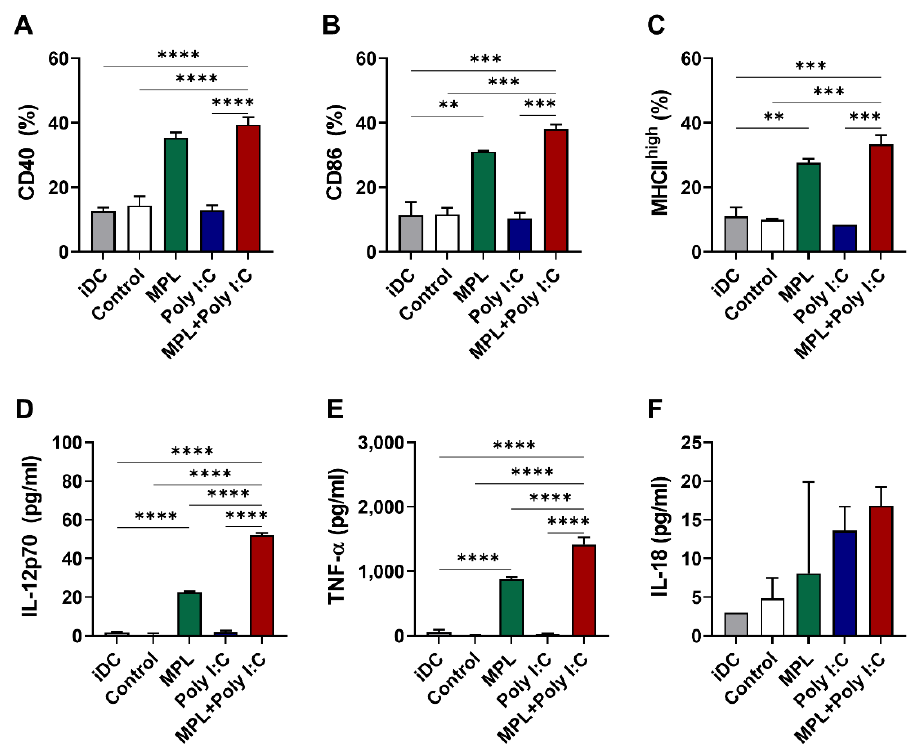
Figure 5. In vitro activation of immature DCs by adjuvant-activated NK cells. Immature DCs were co-cultured with adjuvants pre-treated NK cells isolated from spleen cells of naïve C57BL/6 mice. After two days of co-culture, the cells were harvested and analyzed with the DC activation marker expressions by flow cytometry. The culture supernatants were used for measurement of cytokine production. The percentages of CD40 ( A ), CD86 (B ), and MHCII high ( C ) expression on DCs co-culture with the activated NK cells. The level of IL-12p70 ( D ), TNF- α ( E ), and IL-18 ( F ) were measured by ELISA. The data show the mean ± SD. Statistical analysis between groups were performed by one- way ANOVA and Tukey’s multiple comparison test. **; p < 0.0021, ***; p < 0.0002 and ****; p < 0.0001.